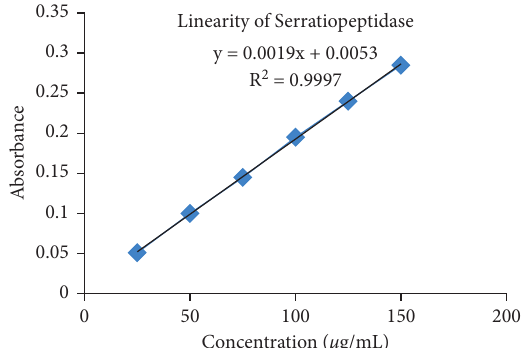
Figure 2: UV standard curve and linearity of SRP in the concentration range of 25–150 µ g/mL in water at